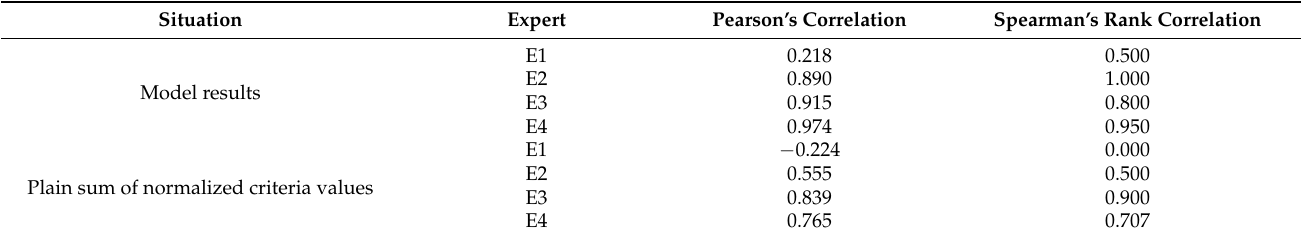
Table 7. Correlation between model results and experts’ opinions.